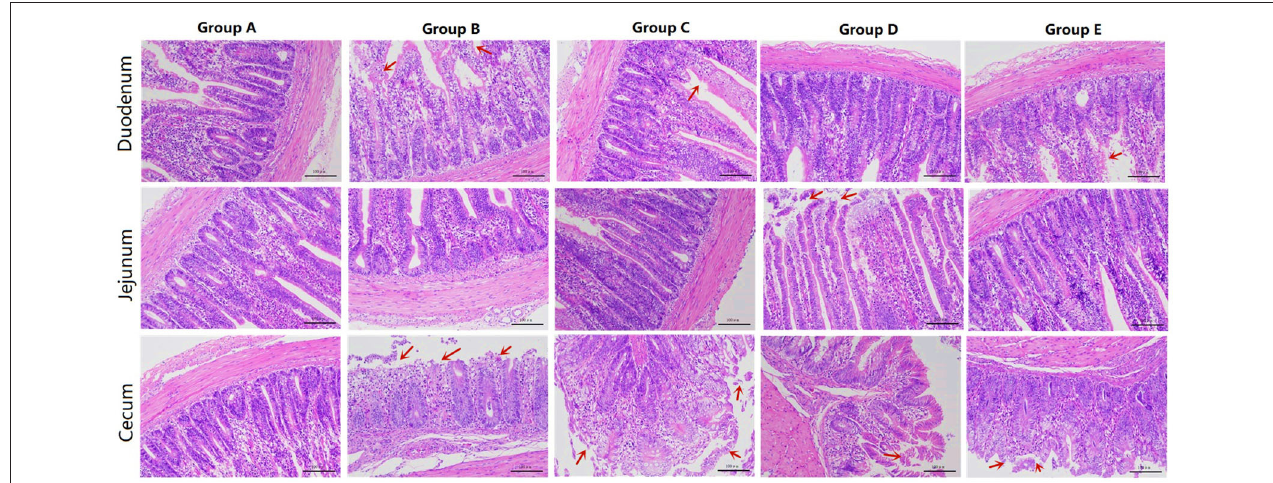
FIGURE 1 | HE sections of different treatment groups. Group A, control group; Group B, infection group; Group C, JYBR-190 pre-fed group; Group D, JYBR-190 fed group; Group E, antibiotic group.